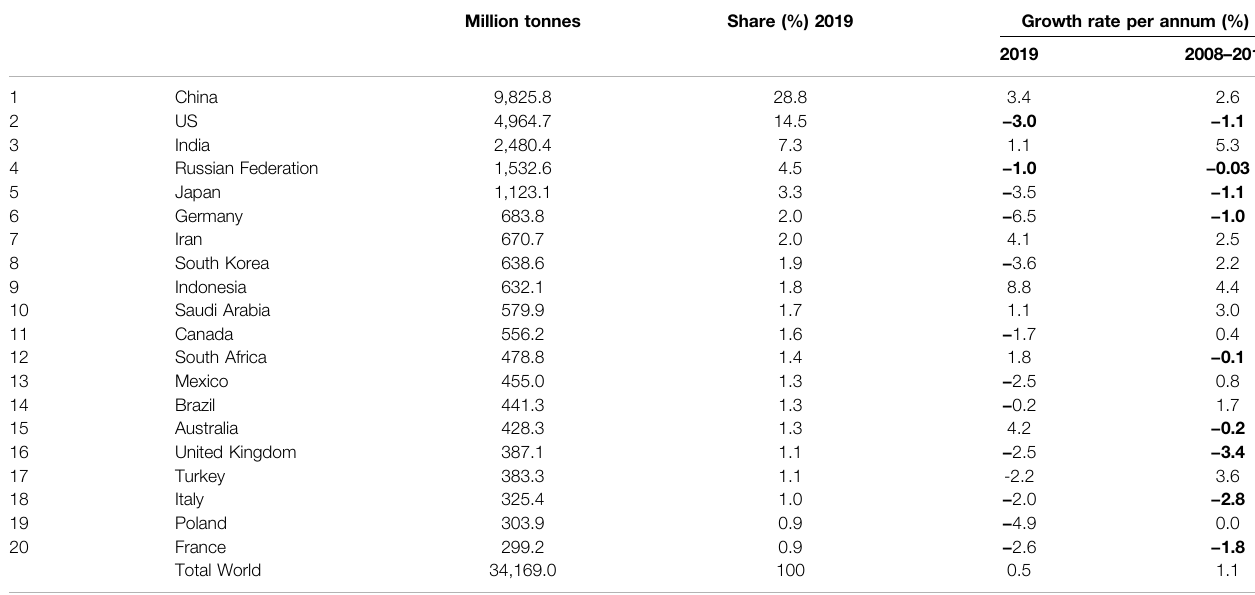
TABLE 2 | Countries rank of carbon